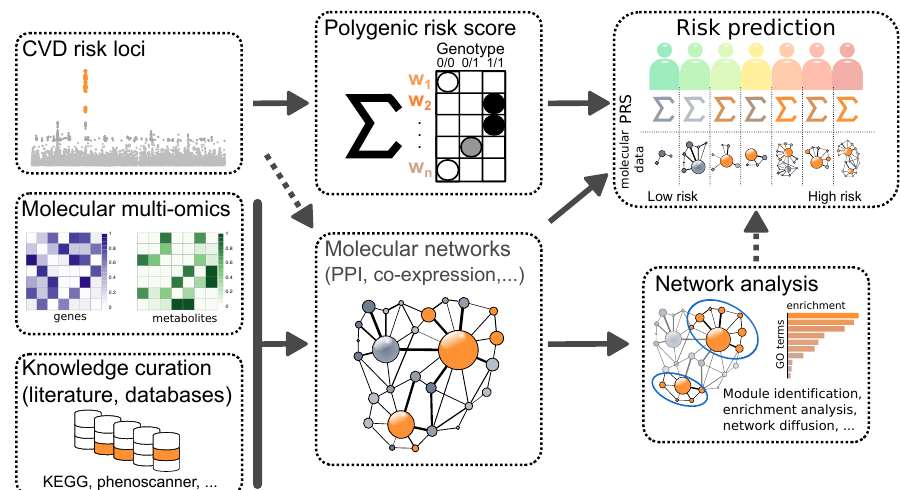
Figure 1. Overview of how molecular data can be used for understanding and predicting the risk of recurrent cardiovascular events. Genome-wide association studies (GWAS) can be used to identify CVD risk loci. Weights obtained from GWAS can be used to calculate a polygenic risk score. Moreover, the GWAS loci can be combined with multi-omics data and prior knowledge to construct regulatory networks. From these networks, it is possible to extract physiological pathways and network modules, as well as associate the level of activity of distinct network regions with high or low risk. The network information and polygenic risk score can be integrated together to improve risk prediction of recurrent cardiovascular